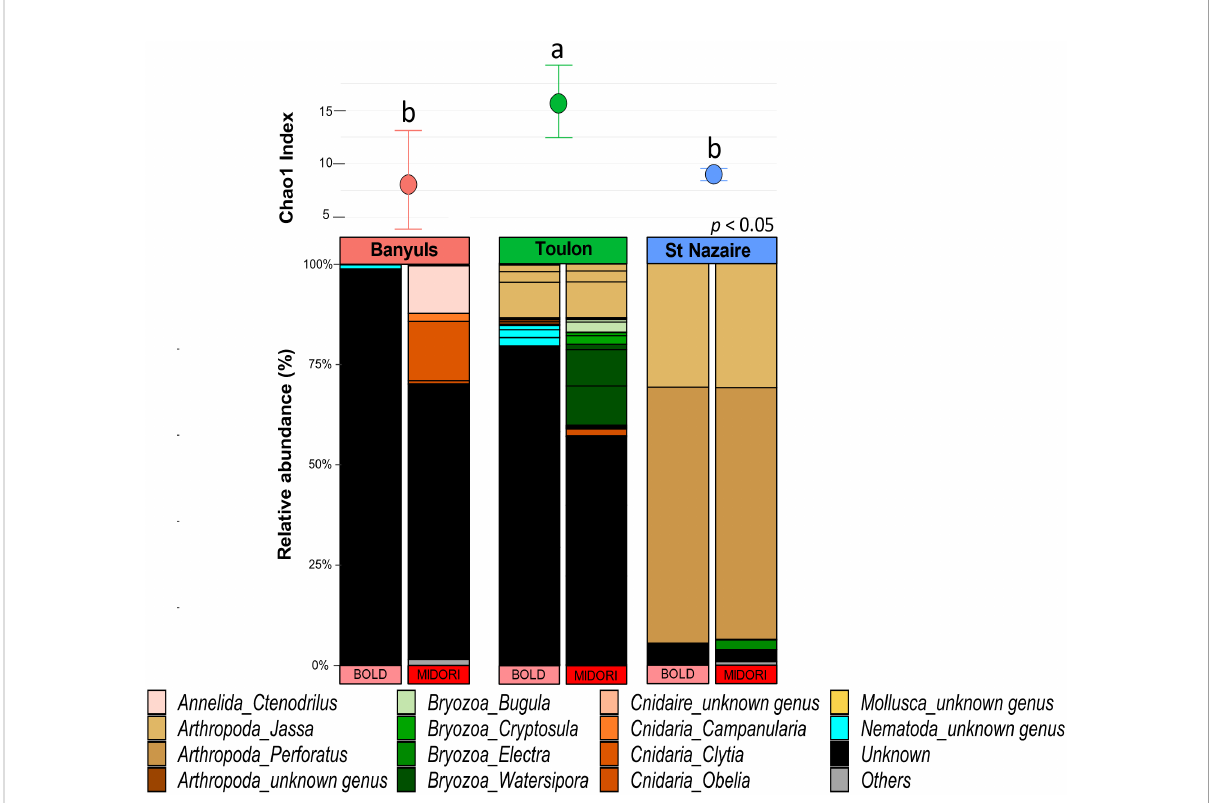
FIGURE 6 Diversity and composition of top eukaryote genera within each site for COI gene. Barplots were represented in relative abundance (> 0.1%) of each taxonomic group of eukaryotes. Above the barplot, graph shows chao1 index at each site (Banyuls, Toulon, Saint-Nazaire). Letters above boxplots represent pairwise comparisons between